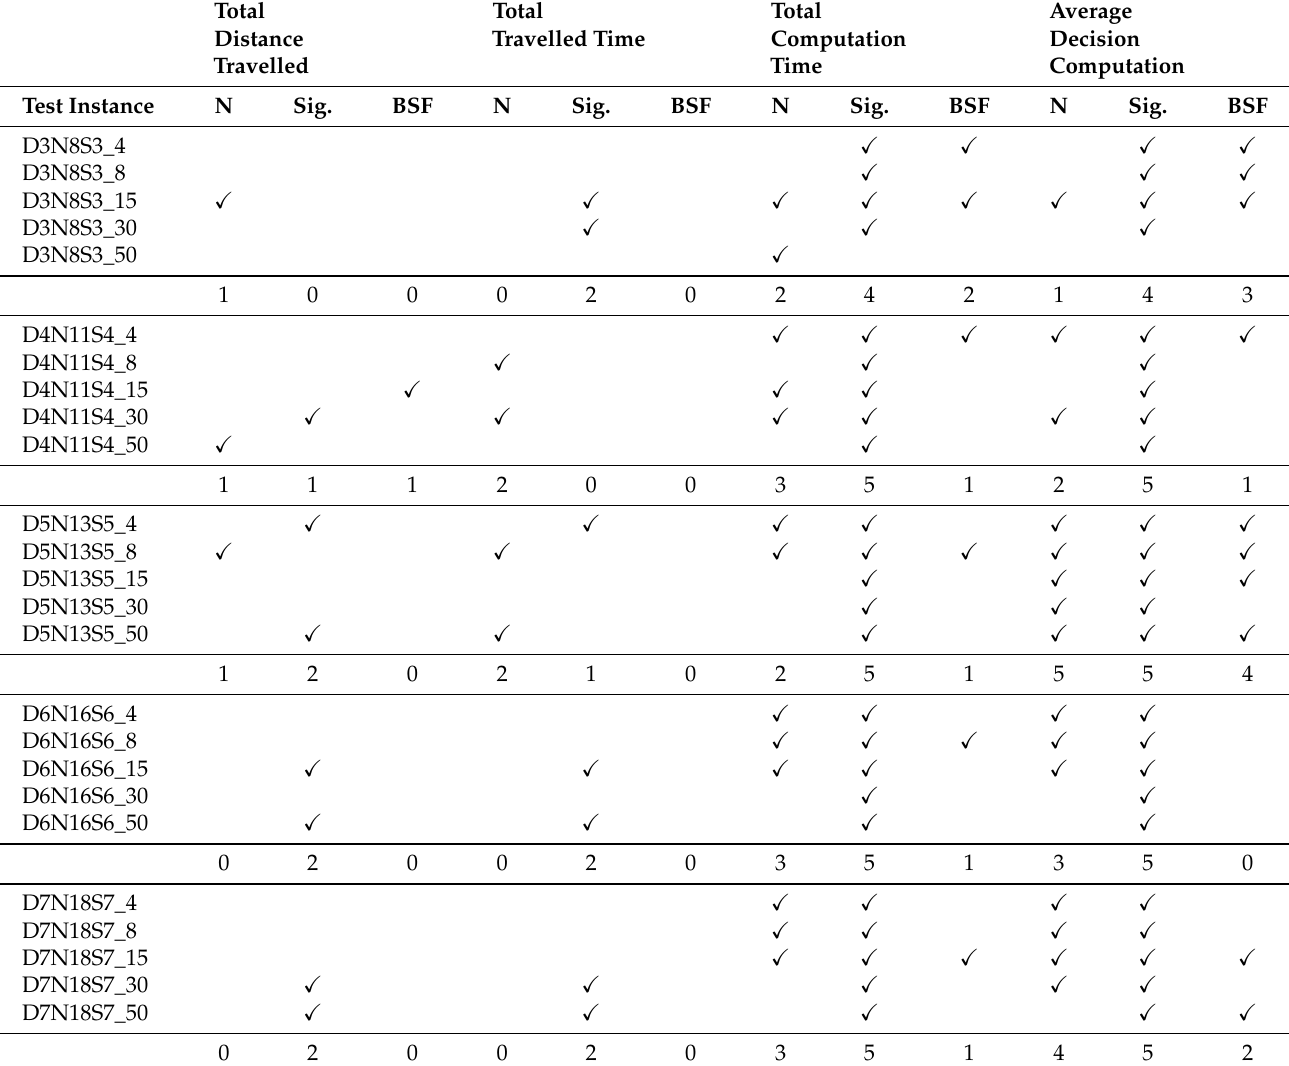
Table A3. PDS_RA performance with TBIH-2 application as base